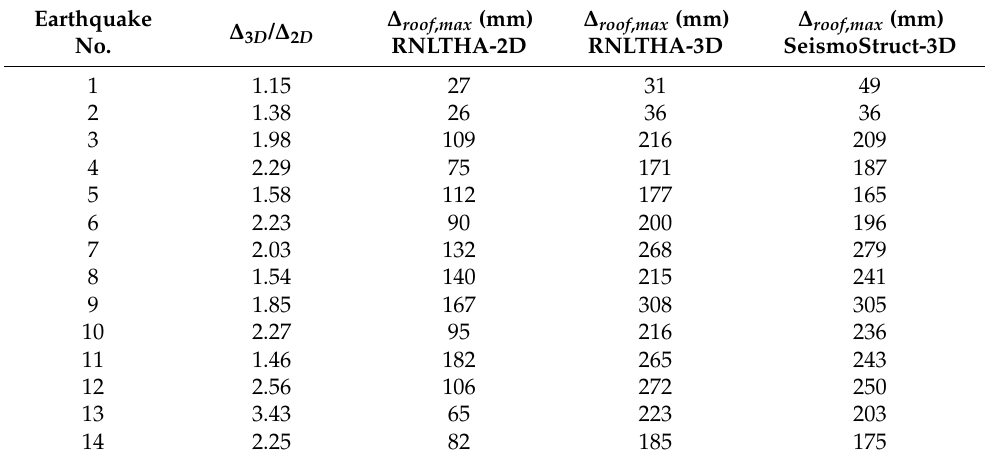
Table A6. Comparison of maximum 3D roof displacement of case study building #2 obtained from RNLTHA-3D and SeismoStruct for each accelerogram.